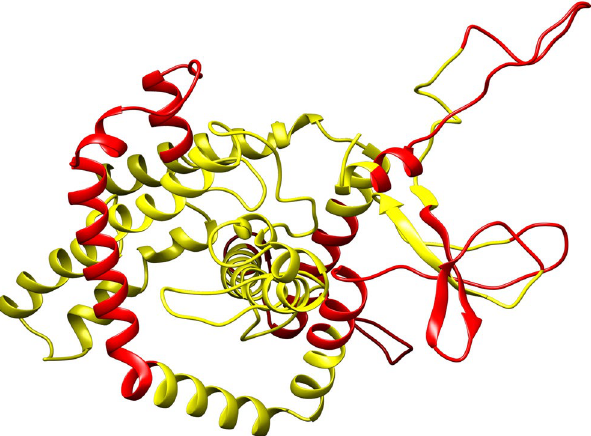
Figure 2. IFN- γ inducing and discontinuous B-cell epitopes representation in final vaccine model ( A ) Red color sequences depict IFN - γ inducing epitopes in the modeled structure. ( B ) Magenta color spheres show discontinuous B-cell epitopes in the 3D model of multi-epitope